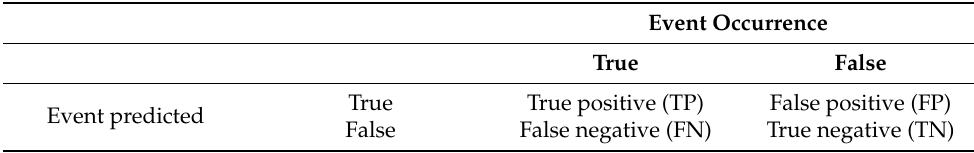
Table 4. The summarization of a confusion